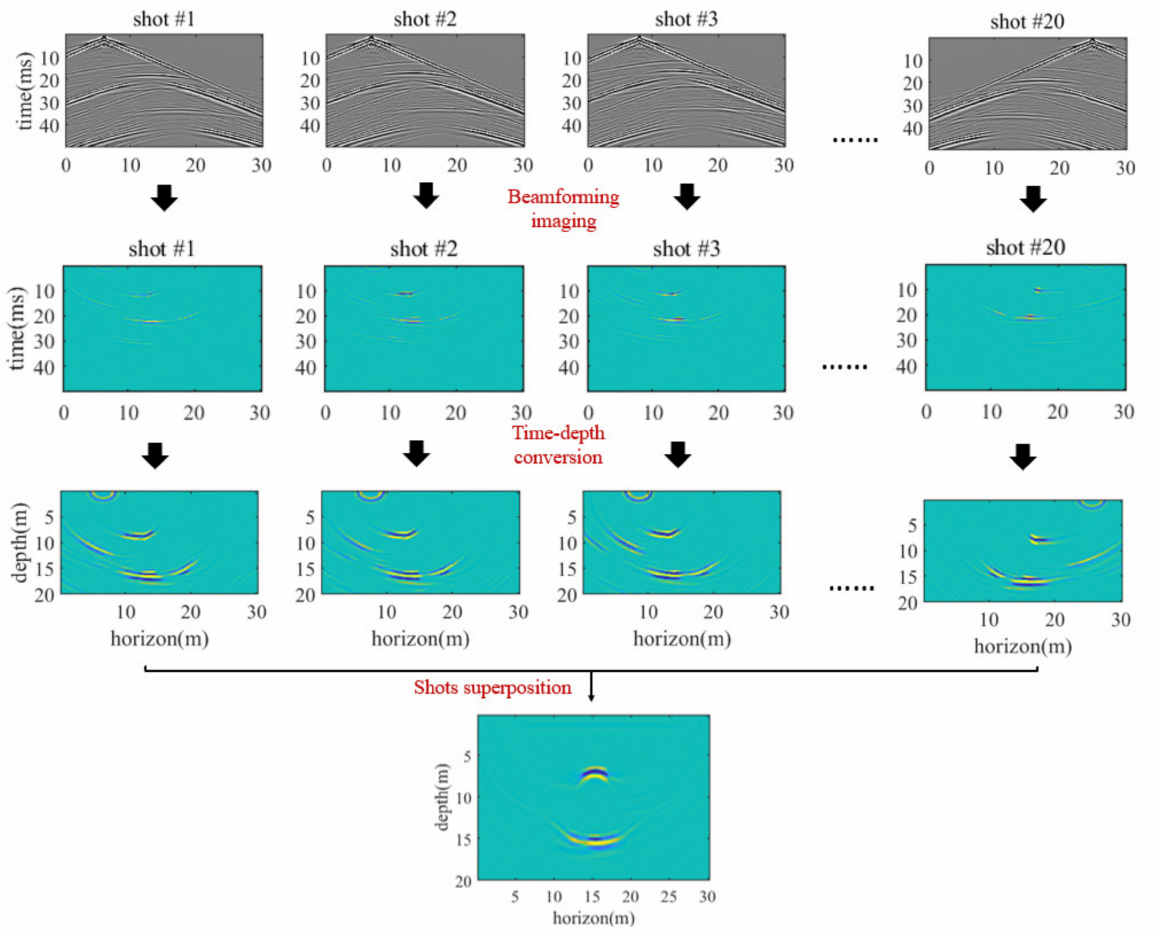
Figure 6. Stacked MVSS beamforming image of 20